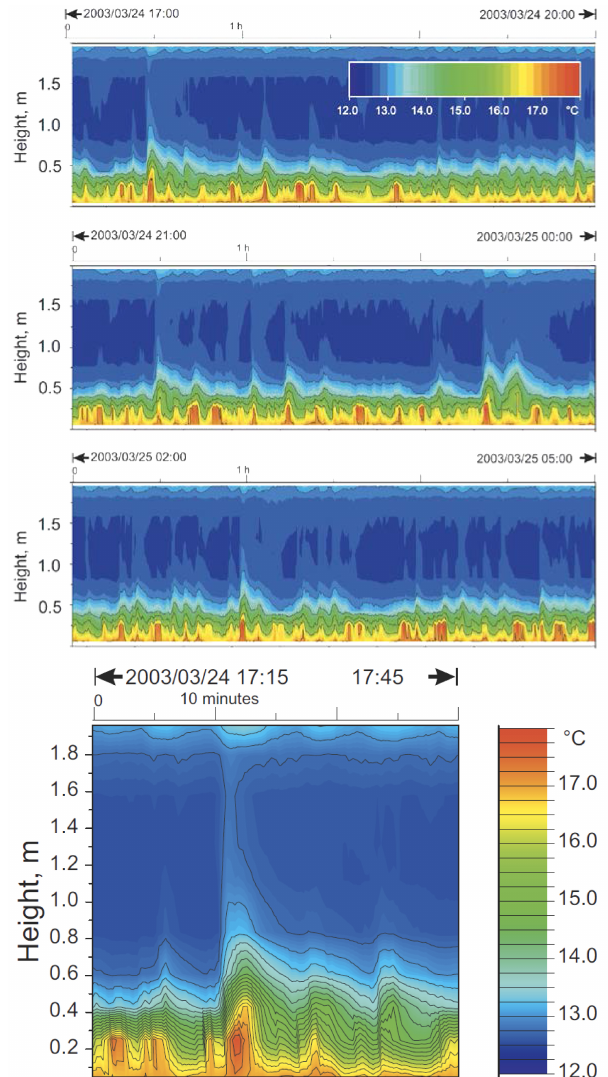
Figure 12. Temperatures in space–time domain during the three 3h intervals (a) and 30min (b) of the A3 heating